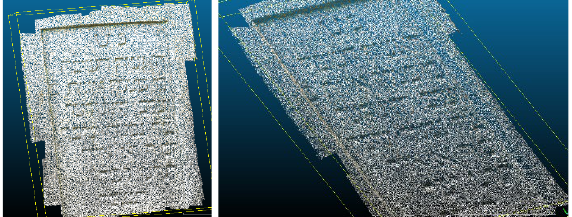
Figure 8. Examples of gravestones captured with BLK 360 laser